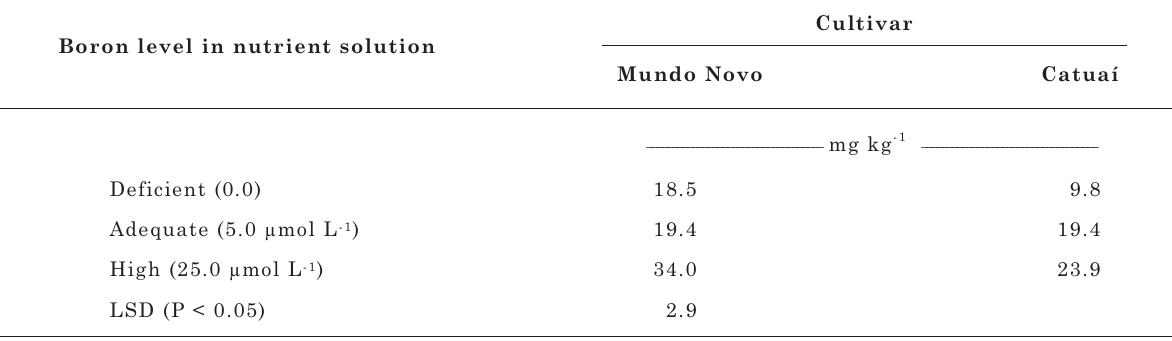
Table 1. Boron concentrations in coffee leaves as affected by cultivar and B in the nutrient